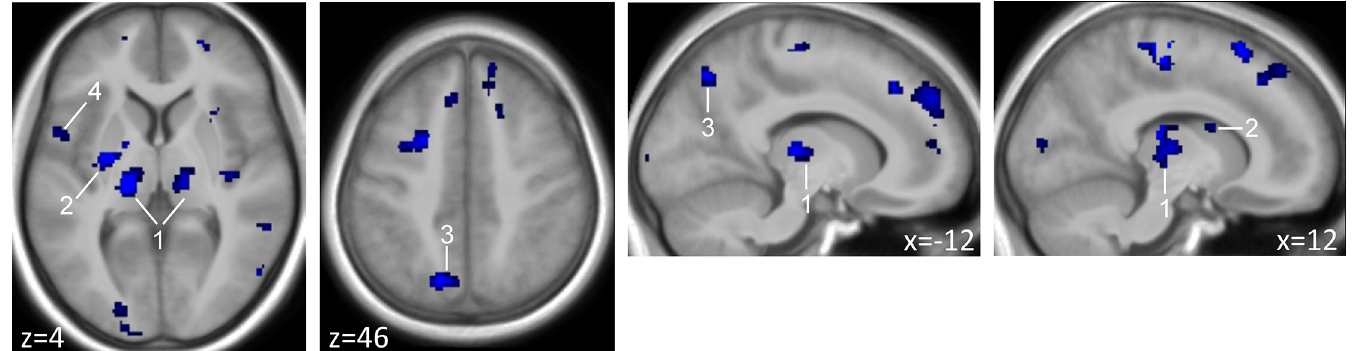
Fig 2. Identified brain regions that were most relevant for the differentiation of CHRNA4 and DRD2 polymorphisms. The PLS-DA based on the contrasted BOLD estimates between the nicotine and placebo treatment sessions during invalid trials. The nicotine-induced main variance in these regions was able to successfully predict the four genetic groups (see Fig 4). Regions are displayed at VIP threshold (cid:3) 1.28 (see methods section), cluster extent threshold k (cid:3) 40. (1) Pulvinar nuclei of the thalamus, (2) putamen/striatum, (3) precuneus, (4) insula; see Table 1 for a complete